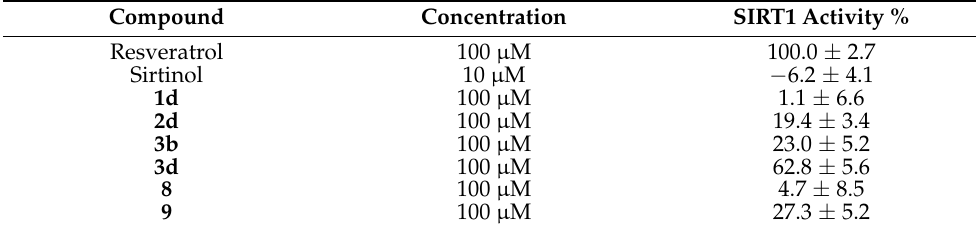
Figure 4. Effects of the screened compounds on isolated SIRT1 enzyme activity. SIRT1 activity is expressed as % of the effect promoted by the reference compound resveratrol (Resv) 100 µM. The sirtuin inhibitor sirtinol (Sirt) 10 µM was used as a negative control. Results are shown as mean ± SEM. * indicates significant difference vs. vehicle (*** p < 0.001). Table 3. Activity (%) of isolated SIRT1 enzyme in the presence of the reference activator resveratrol (100 µ M), the sirtuin inhibitor sirtinol (10 µ M), or the screened compounds (all 100 µ M). Results are shown as mean ±